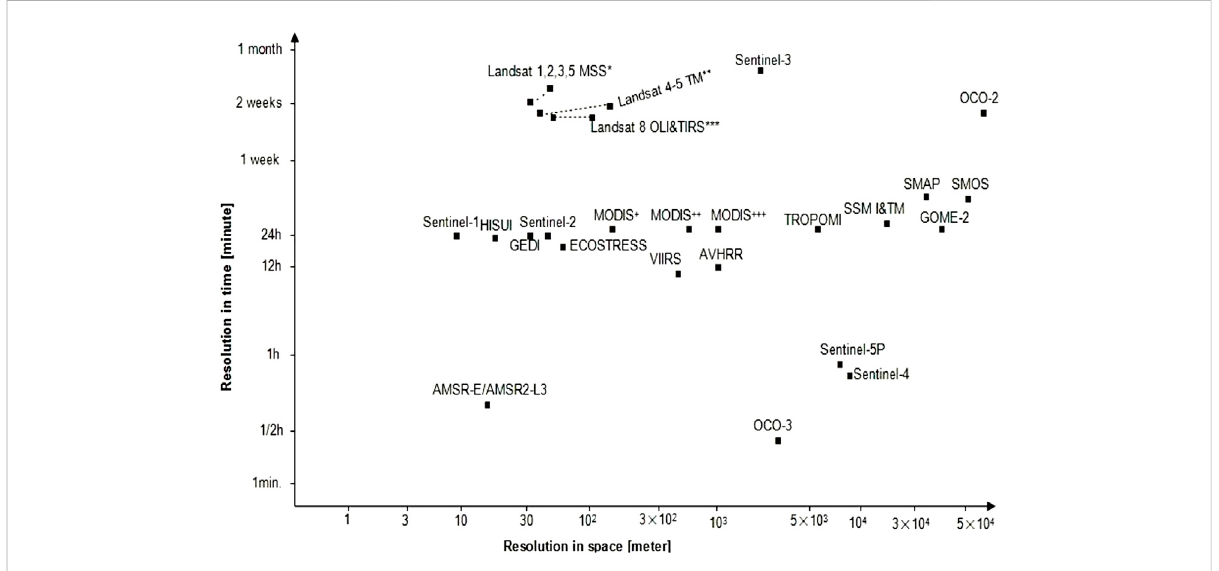
FIGURE 5 Comparison of RS satellites. The multispectral scanner (MSS)* its original pixel size was 79 m × 57 m, where the production systems now resampled the data to 60 m. The thematic mapper (TM)** band 6 was acquired at 120 m resolution, but products are resampled to 30 m pixels. Therefore,theLandsat8operationallandimager(OLI)andthermalinfraredsensor(TIRS)***,theTIRSbandsareacquiredat100 mresolutionbutare resampled to 30 m in the delivered data product. The spectral band placement for each sensor is visually displayed. The MODIS consists of several bands, including bands 1 – 2 + , bands 3 – 7 ++ , and bands 8 – 36 +++